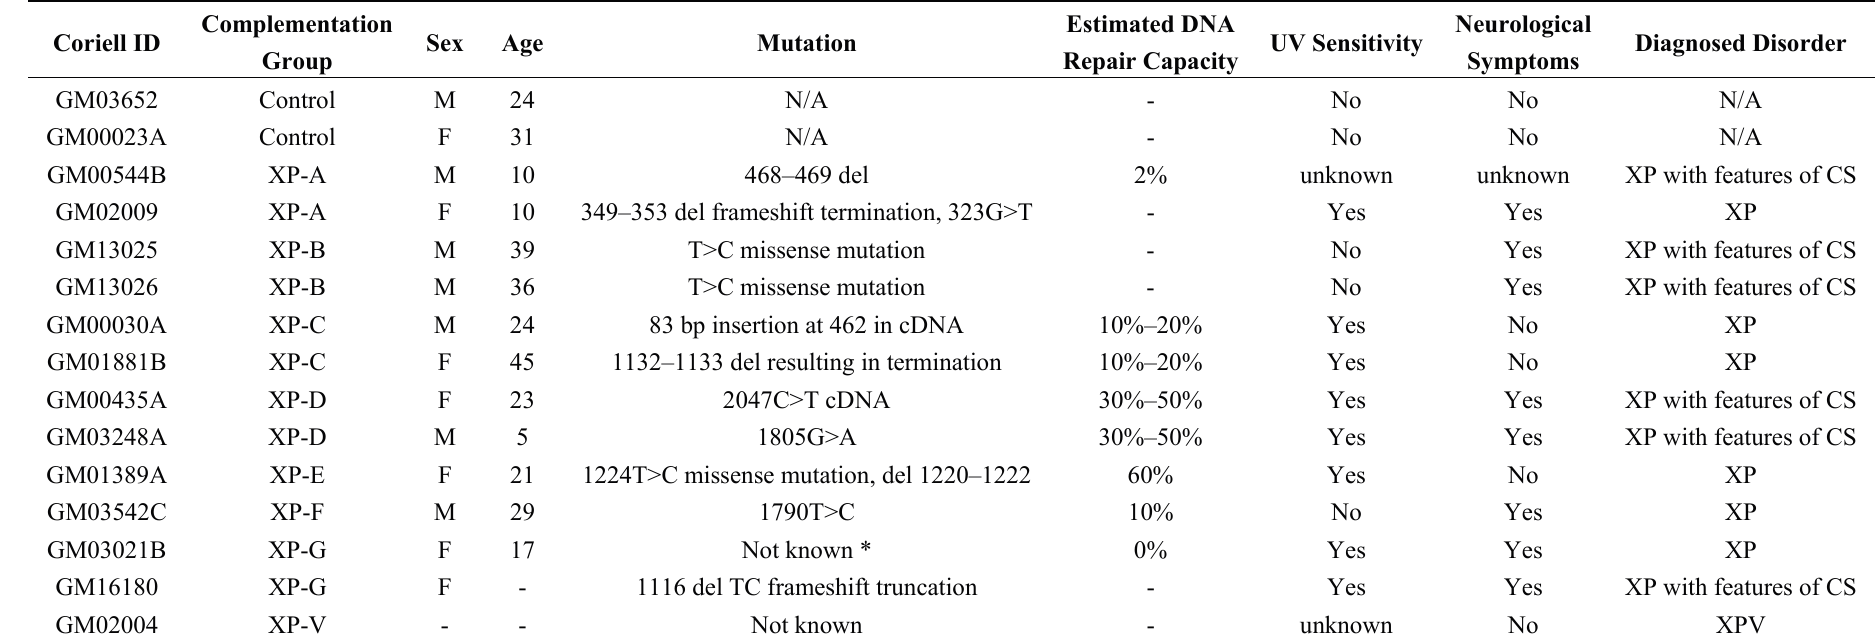
Table 2. Clinical characteristics and mutation status of XP and control fibroblast cell